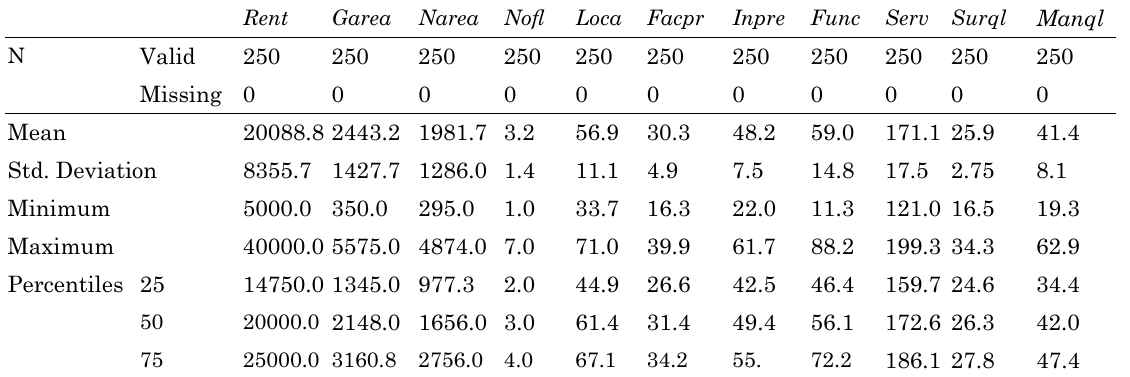
Table 2. Summary statistics of the